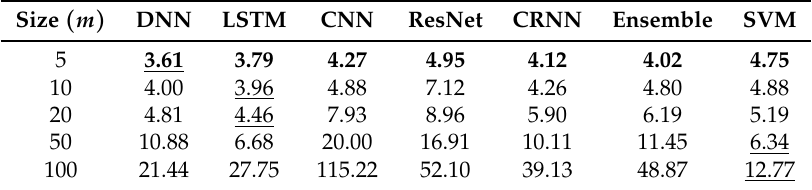
Table 4. Effect of the sequence size m on regression (MAPE, %). The log values of the major features, the sequential partitioning, and the first value-based normalization were used.